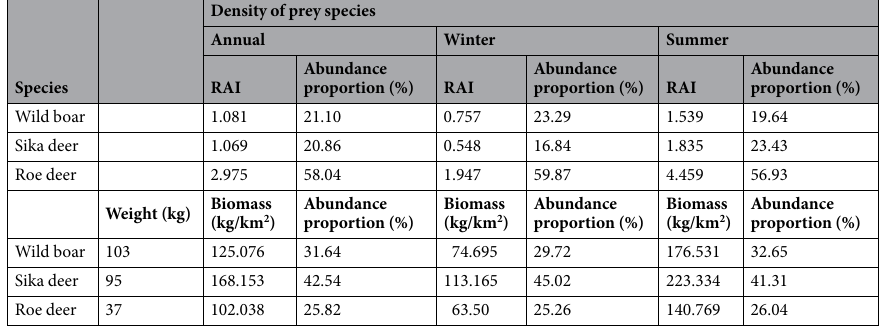
Table 1. The annual and seasonal relative abundance index (RAI and biomass) and biomass densities proportion for wild boar, sika deer and roe deer in NE China. Note: RAI is the relative abundance index from the camera trap data; biomass was also calculated from the camera trap data based on Random Encounter